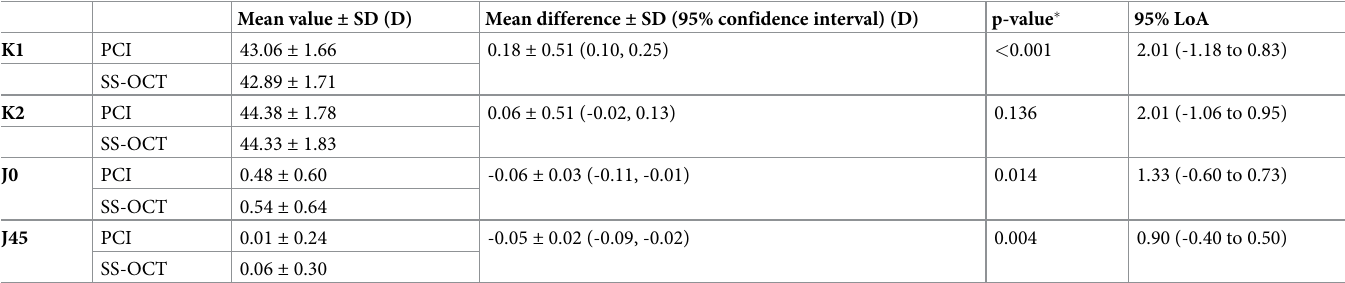
Table 2. Mean value, mean difference, and 95% limit of agreement (LoA) of keratometric values (K1, K2, J0 and J45) between two biometry. Mean value ± SD